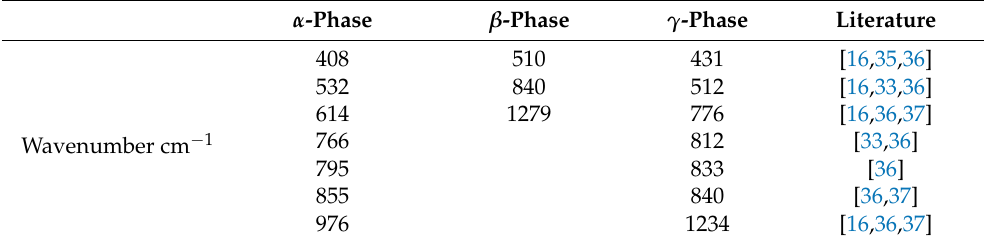
Table 1. Summary table of the reported wavenumber values of alpha beta and gamma phases in literature.